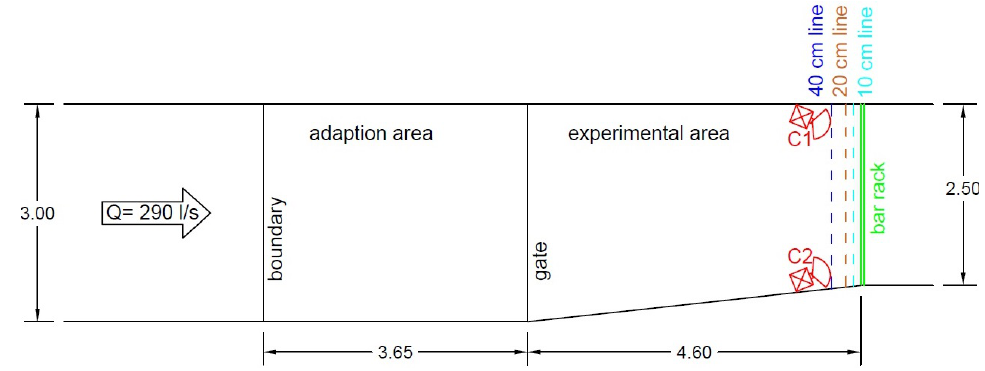
Figure 1. Plan view of the experimental channel with upstream boundary and gate between adaption and experimental area, camera position (C1 and C2) in red, bar rack within the flume (green), 40, 20 and 10 cm lines at the channel bed (blue, orange, cyan,